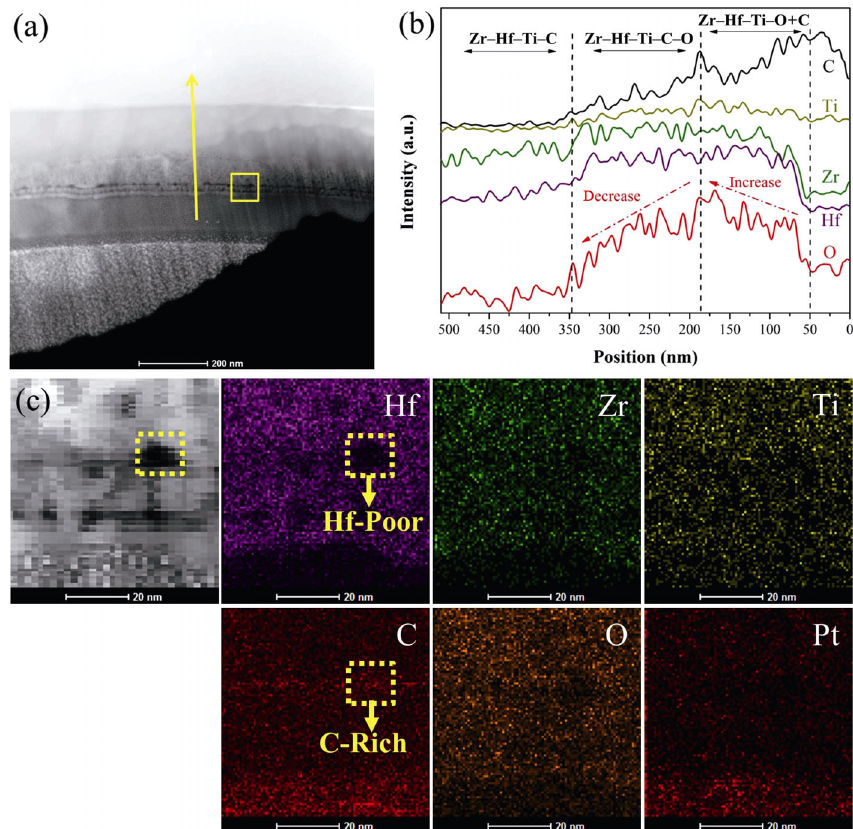
Fig. 9 EDS analysis of Zr 0.3 Hf 0.5 Ti 0.2 C 0.8 after being oxidized at 500 ℃ : (a) high-angle annular dark field scanning transmission electron microscopy (HAADF-STEM) image, (b) element scanning along the line position in (a), and (c) element mapping of solid line area in